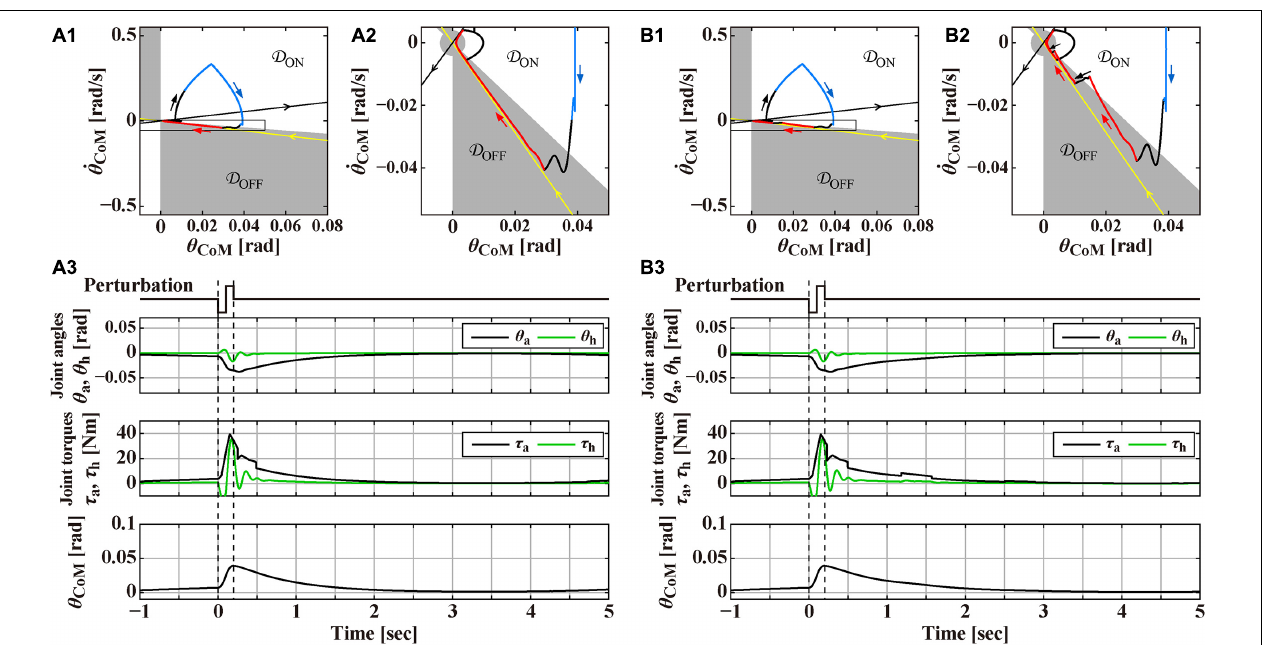
FIGURE 1 | Responses to the support-surface perturbation of the double inverted pendulum model stabilized by an intermittent feedback controller and a reflexive control that operates transiently only for a short period of time after the perturbation at t = 0 s, to be compared with Figure 3 for the human experiment. The reflexive control is terminated at t = 0.25 s in panel (A) and t = 0.23 s in panel (B) . Overall structure of the response to the perturbation can be grasped by a rounded triangular trajectory of the state point in the θ CoM − ˙ θ CoM phase plane of the panels (A1,B1) , where the white ( D ON ) and gray ( D OFF ) areas in the θ CoM − ˙ θ CoM phase plane represents the ON and OFF regions of the intermittent control. Panels (A2,B2) are the magnifications of the squared areas of (A1,B1) , respectively. Black and red segments of the triangular trajectory are for the system, respectively, with the active feedback control (switched ON) and without the active feedback control (switched OFF). Blue segment of the trajectory is for the system with the reflexive control. Straight-shaped yellow and black lines, directing to and departing from the origin, respectively, represent the stable and unstable manifolds of the system in the absence of (i.e., switched OFF) active feedback control. Panels (A3,B3) are the time profiles of the ankle joint angle θ a and the hip joint angle θ h , the corresponding joint torques, and the tilt angle θ CoM for the total body CoM in response to the perturbation. See text for